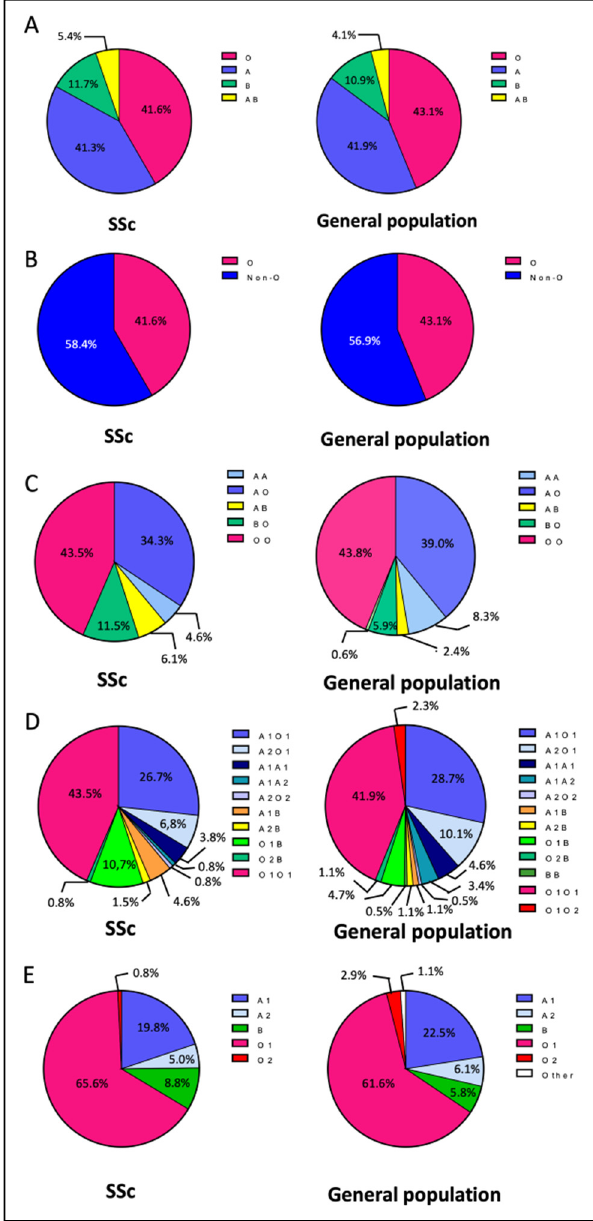
Figure 2. ABO blood group repartition in the SSc cohort and in the general population. ( A ) Phe- notypical ABO blood group repartition in the SSc population compared to that of the French